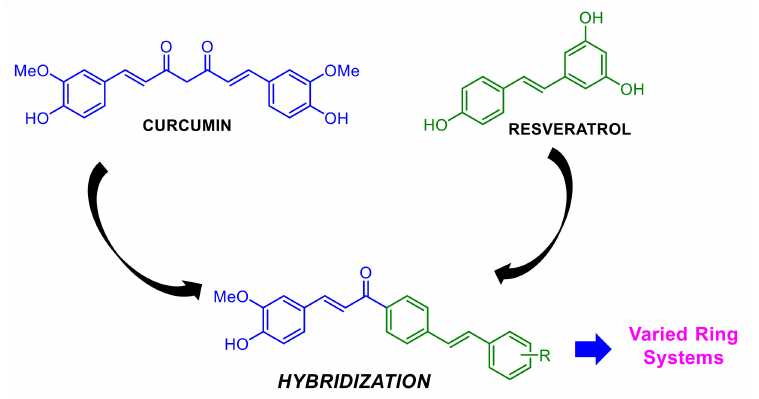
Figure 2. Design of hybrids based on curcumin and resveratrol as anti-cancer